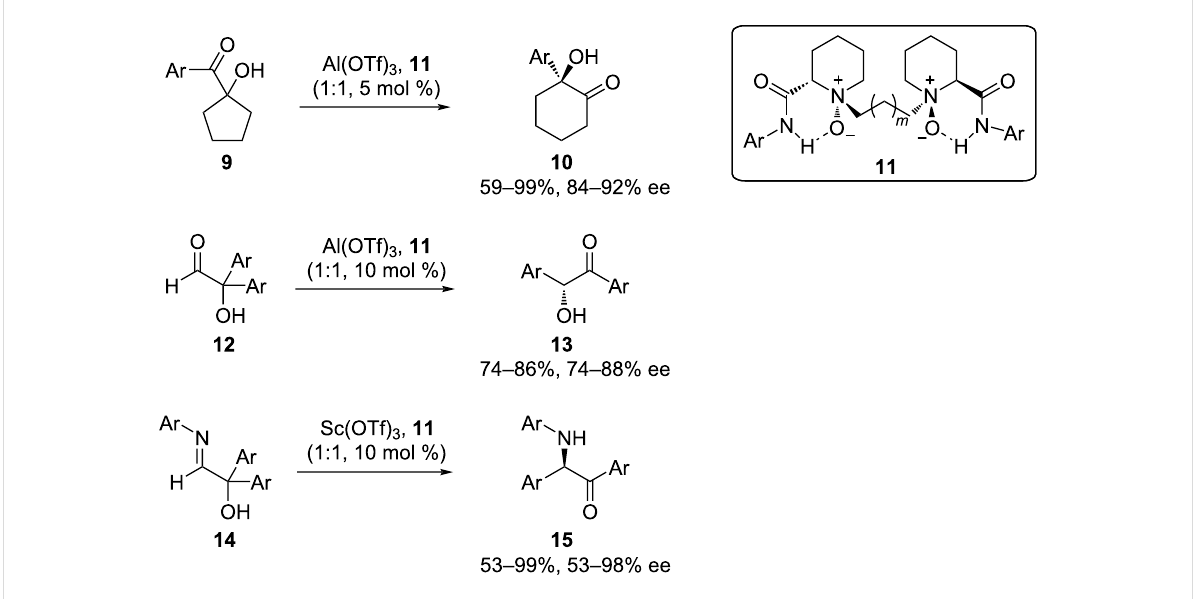
Figure 4: Enantioselective rearrangement of ketols 9 and 12 and hydroxyaldimine 14 catalyzed by Al(III) or Sc(III) liganded by 11 . Ligand 11 : for 9 , m = 1 and Ar = 2,6-iPr 2 C 6 H 3 ; for 12 , m = 1 and Ar = 2,6-Me 2 C 6 H 3 ; and for 14 , m = 0 and Ar = 2,4,6-iPr 3 C 6 H 2 .